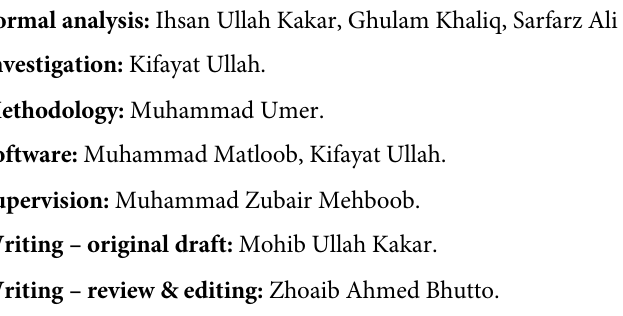
S1 Table. List of all 227 missense SNPs retrieved from Ensembl database and their impact by SNPs evaluating